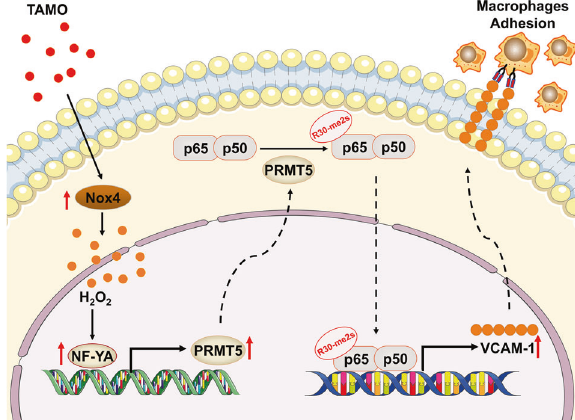
Fig. 8 PRMT5 promotes TMAO-induced VCAM-1 expression via methylation of NF- κ B p65 in VSMC. H 2 O 2 generated from the TMAO-stimulated Nox4 upregulation can promote PRMT5 expres- sion and increase methylation of NF- κ B p65 on R30, leading to the induction of VCAM-1 and macrophage